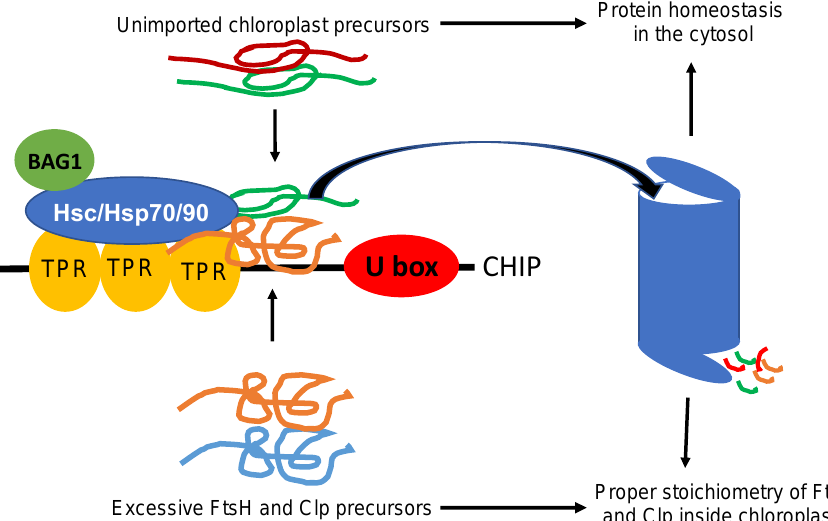
Figure 1. CHIP-mediated chloroplast protein quality control. Molecular chaperones Hsc/Hsp70/90 recognize unimported chloroplast precursors and can switch their role to facilitate protein degradation upon binding the PTR domain of CHIP. CHIP can also directly recognize some chloroplast precursors such as excessive FtsH and Clp precursors. CHIP mediates the ubiquitination in these unwanted or excessive chloroplast precursors and targets their degradation by the 26S proteasome. CHIP-mediated degradation of unimported chloroplast precursor proteins prevents the accumulation of misfolded proteins and helps maintain protein homeostasis in the cytosol. The degradation of excessive FtsH and Clp protein subunits may help maintain proper stoichiometry of these protease complexes inside chloroplasts.